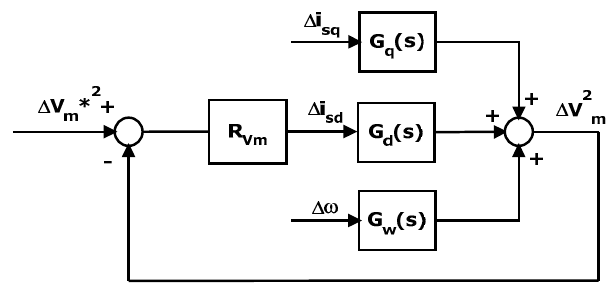
Figure 13. Simplified speed control loop for the synthesis of the regulator.